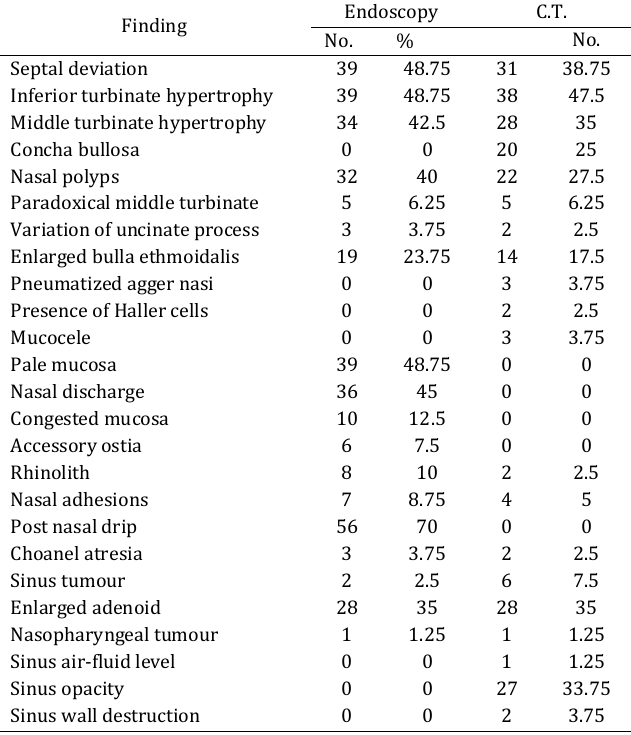
Table 4 Comparison between endoscopic and C.T. scan finding